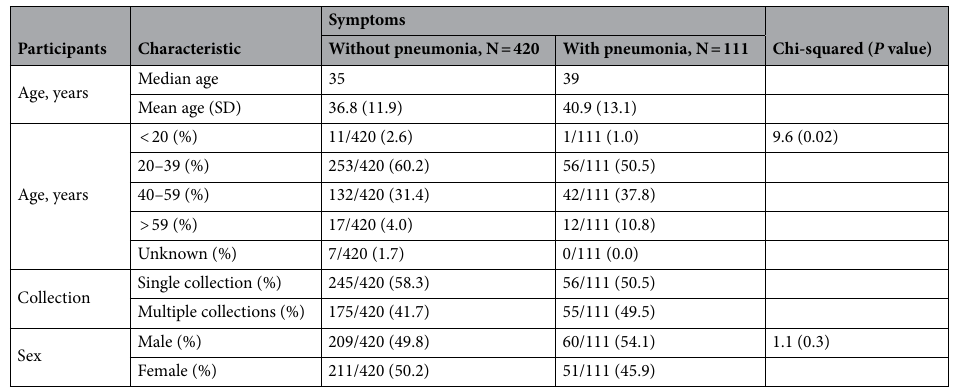
Table 1. Demographic data of participants and specimen collection in this study. SD standard